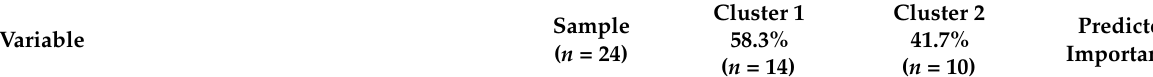
Table 2. Cognitive and affective attitudes of